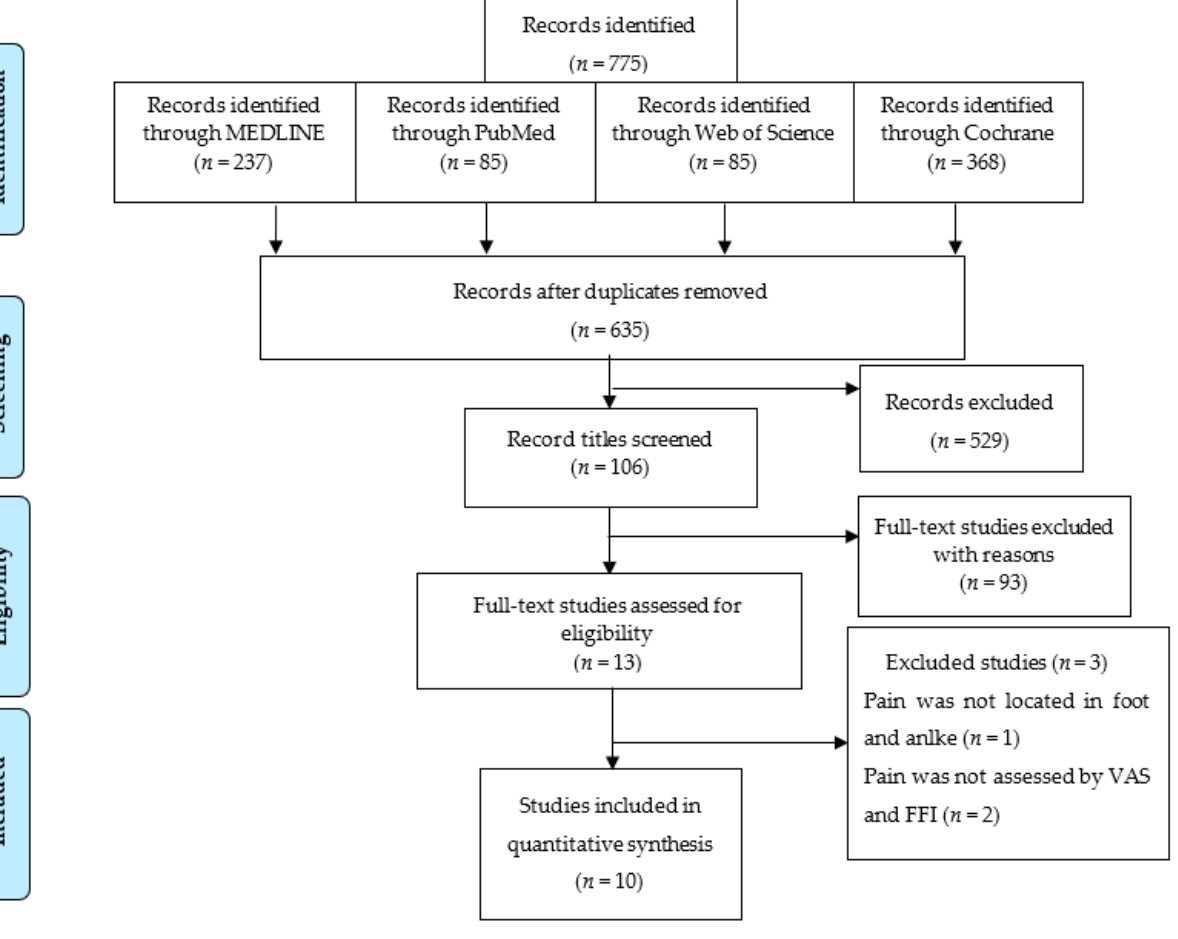
Figure 1. PRISMA flowchart.